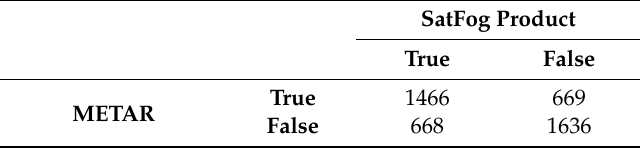
Table 6. Confusion matrix, with t p = 1466, t n = 1636, f p = 668, f n =